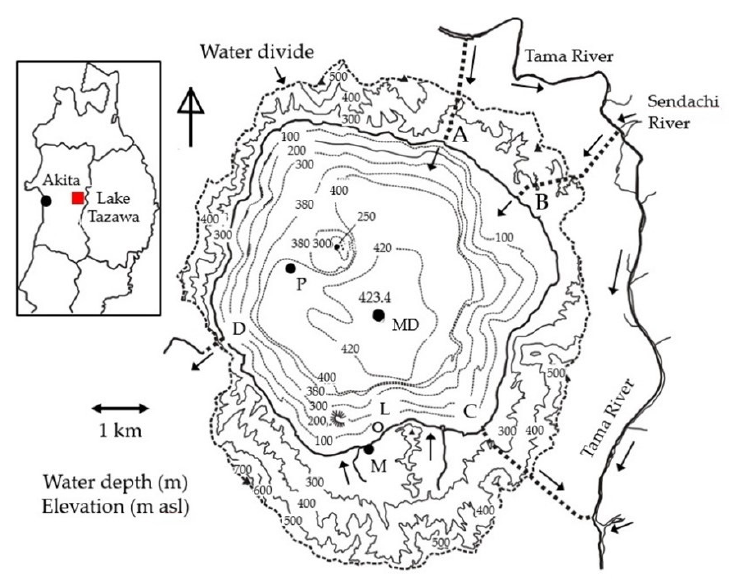
Figure 1. Location of Lake Tazawa in Akita Prefecture, Japan, observation sites and four conduits A, B, C and D (thick dotted lines) on the bathymetric (thin dotted lines) and surrounding topographic (thin solid lines) maps with 100 m contours. MD: Deepest point, M: Meteorological station, L: Monitoring point of lake level, water temperature and electric conductivity (EC), MD and P: Observation points of the ASTD102 profiler.